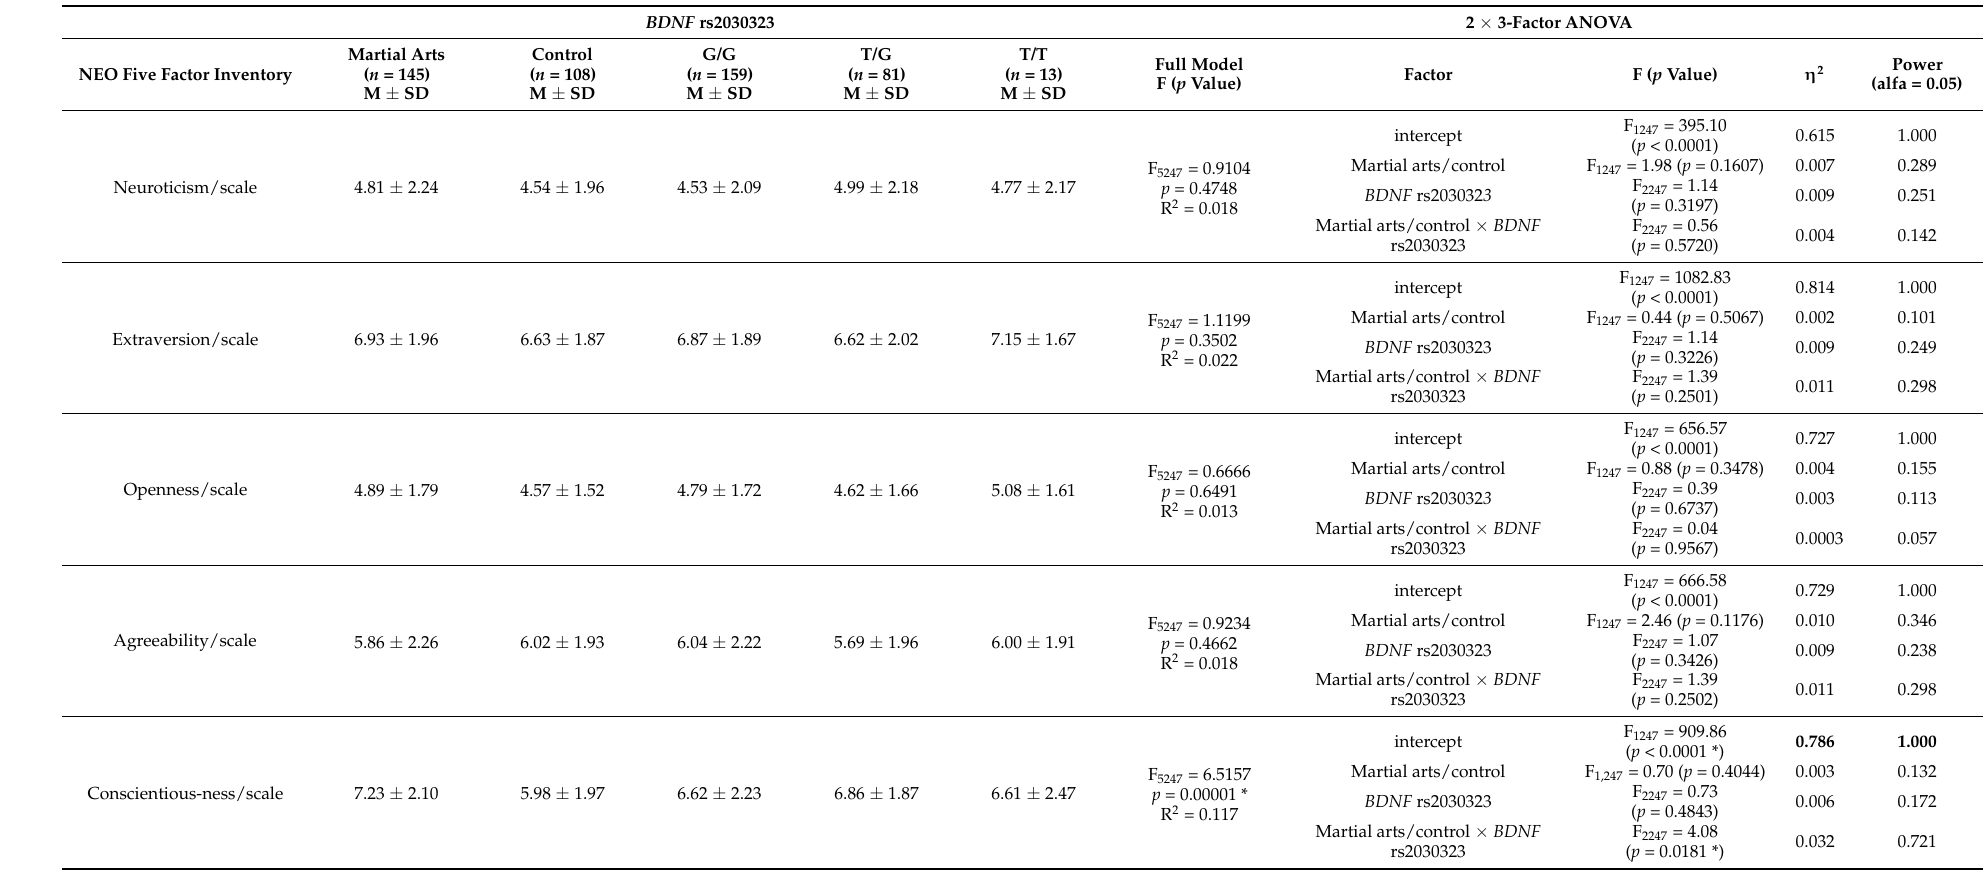
M—mean, SD—standard deviation. *—significant statistical